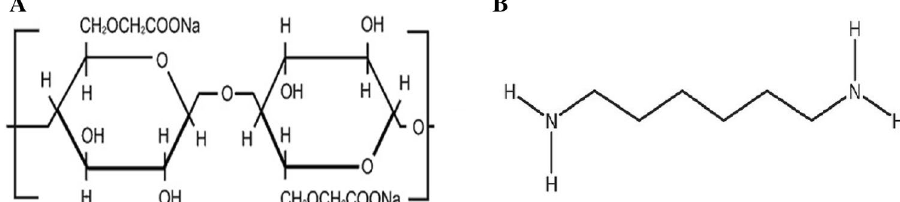
Fig. 1 Chemical structure of